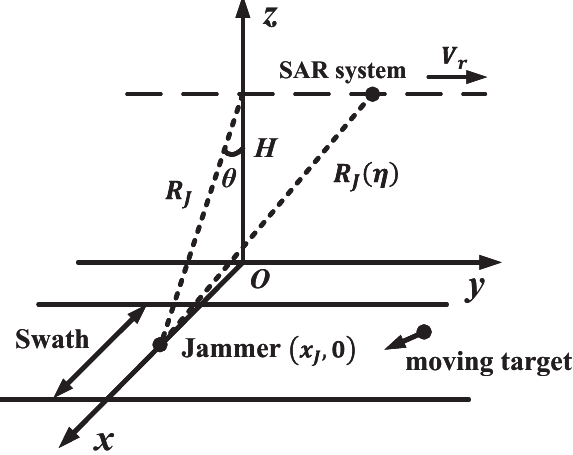
Figure 3. Schematic diagram of motion modulation